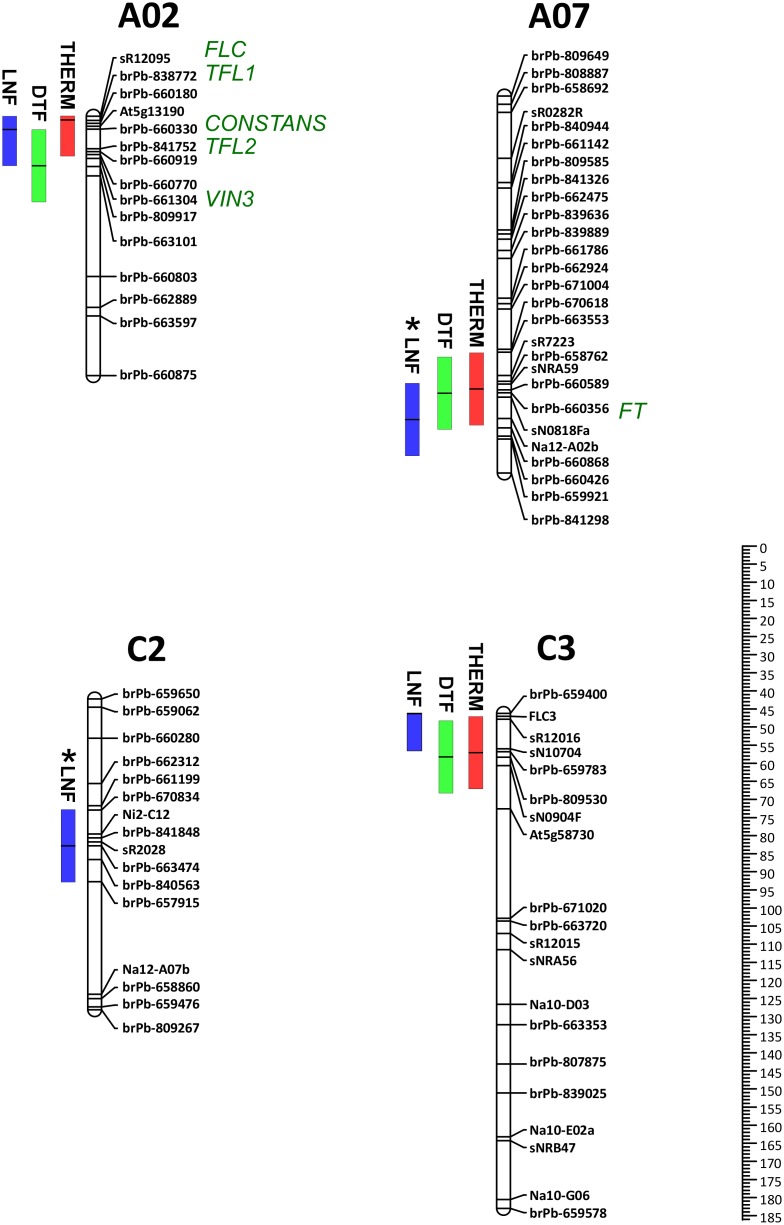
Distribution of flowering time-related QTLs in the LMDH framework map of Brassica napus.Flowering time traits comprised thermal time to flowering (THERM, expressed as degree-days), days to flowering (DTF) and number of leaf nodes at flowering (LNF). Linkage groups are drawn to Kosambi cM scale indicated in the scale bar. QTLs are represented as solid bars to the left of linkage groups with the central bar indicating the centre of each QTL and box showing 10 cM to each side of the centre. The predicted approximate locations of flowering time gene homologues near QTLs are shown to the right of the linkage groups.